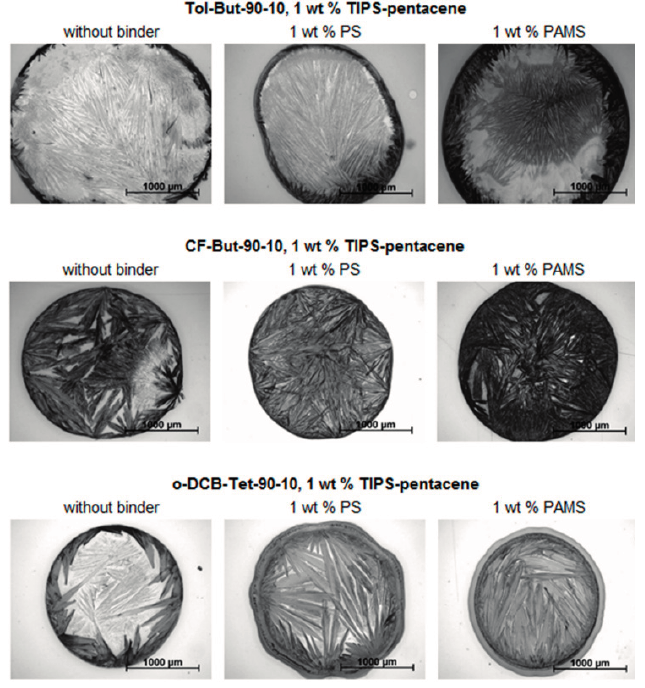
Figure 5. Microscope images of drops of experimental part III with and without binders.